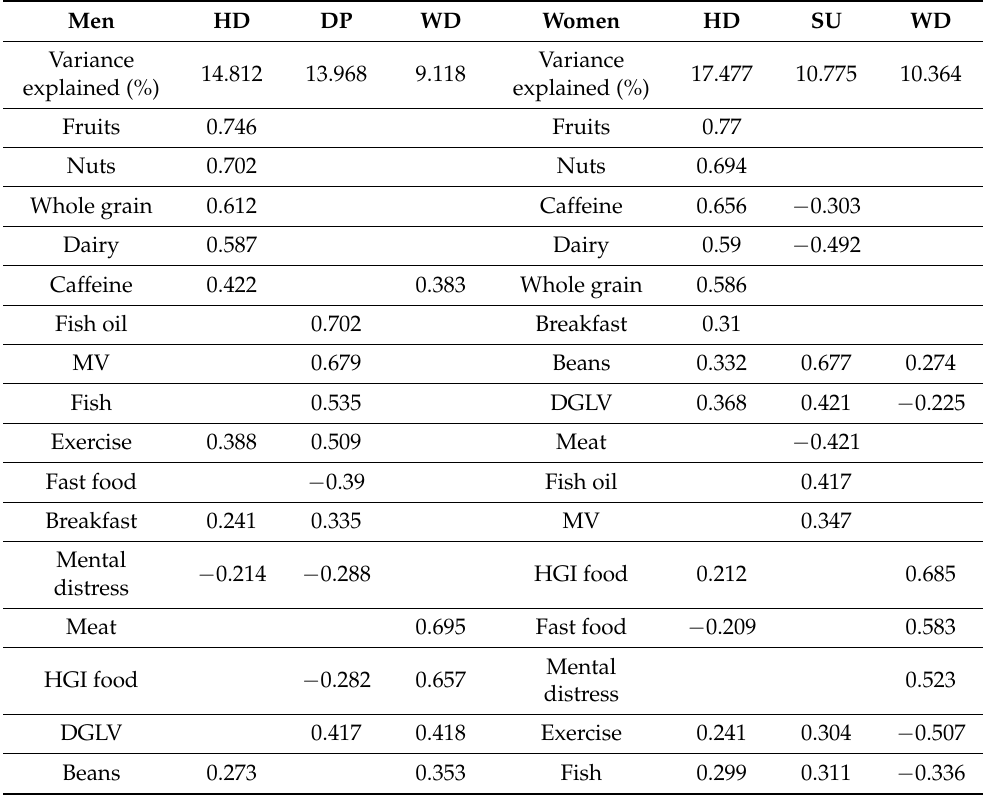
Table 4. Principal component analysis results for mature men and